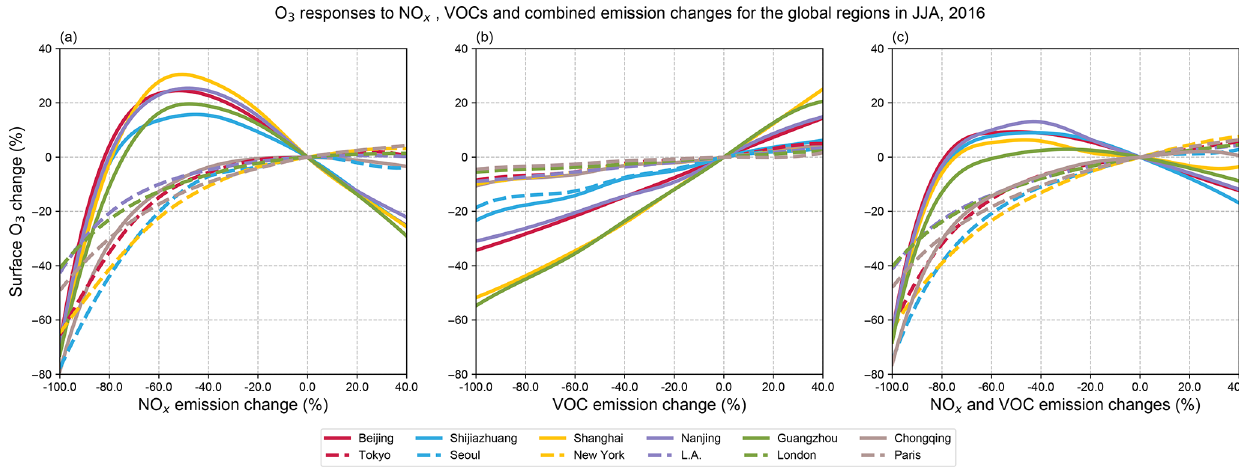
Figure 10. Simulated summer daily mean surface O 3 responses to anthropogenic (a) NO x , (b) VOC, and (c) combined NO x and VOC emission changes in regions across the globe: Tokyo, Seoul, New York, L.A., London, Paris (dashed lines) and those in major industrial regions of China (solid lines) in JJA,